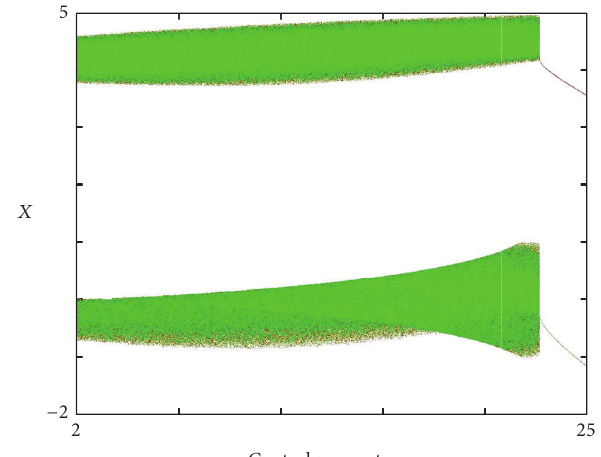
Figure 5: Bifurcation diagram using 𝑎 as control parameter for two different initial conditions. In red color (1,1,1,1) and in green color (−2,−2, −2,−2) . Parameters: {𝑏 = 2 , 𝑐 = 3 , and 𝑑 = 10} .